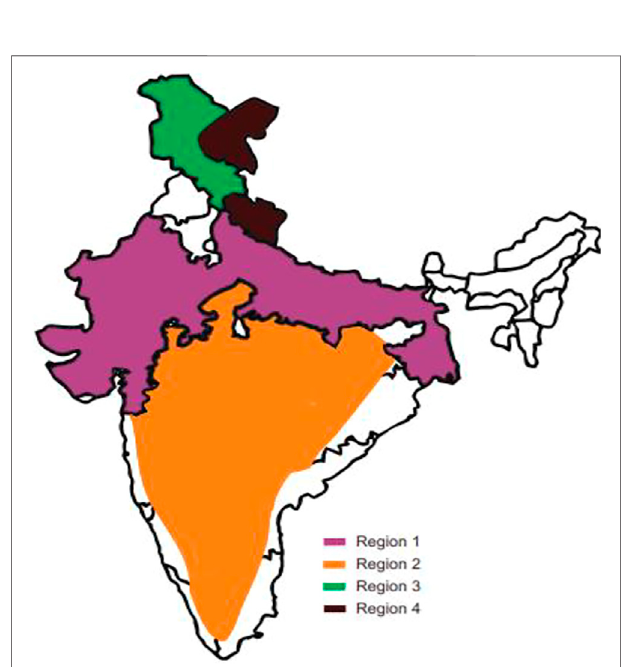
FIGURE 4 | Distribution of shikonin-producing plants across India. Region 1 — Rajasthan, Gujrat, Ganga plains, Region 2 — Peninsular India, Region3and4 — Spiti(colddesertareasofHimachalPradesh),Uttarakhand, Leh and Ladakh. (Refer to Table 3 ).